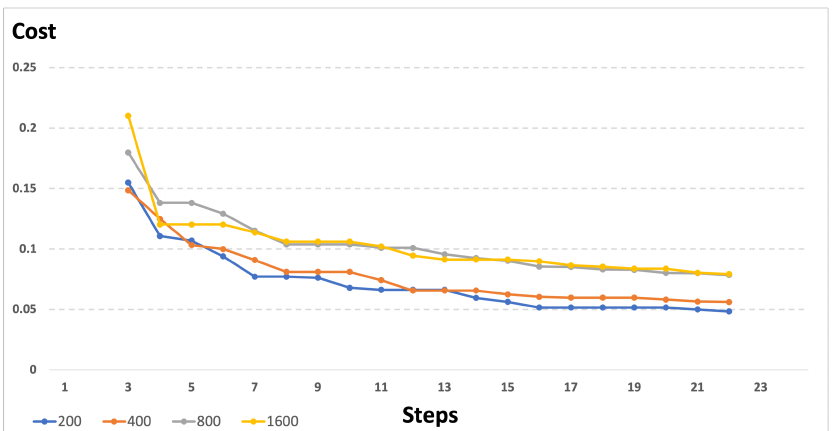
Figure 8. AC for the low-cost bounded degree spanning tree algorithm after 20 steps.